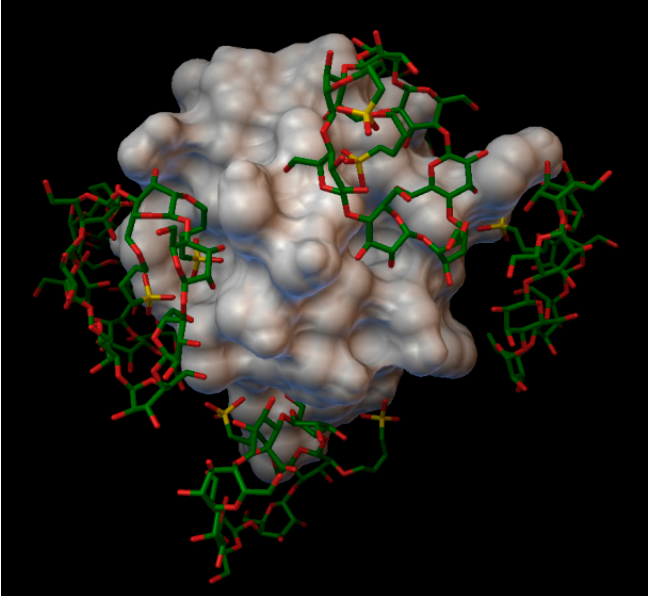
Figure 13. Insulin-sulfobutylether- β -cyclodextrin (DS 2) complex. The insulin molecular surface is marked with white and the cyclodextrin molecules are marked with green and red licorice.